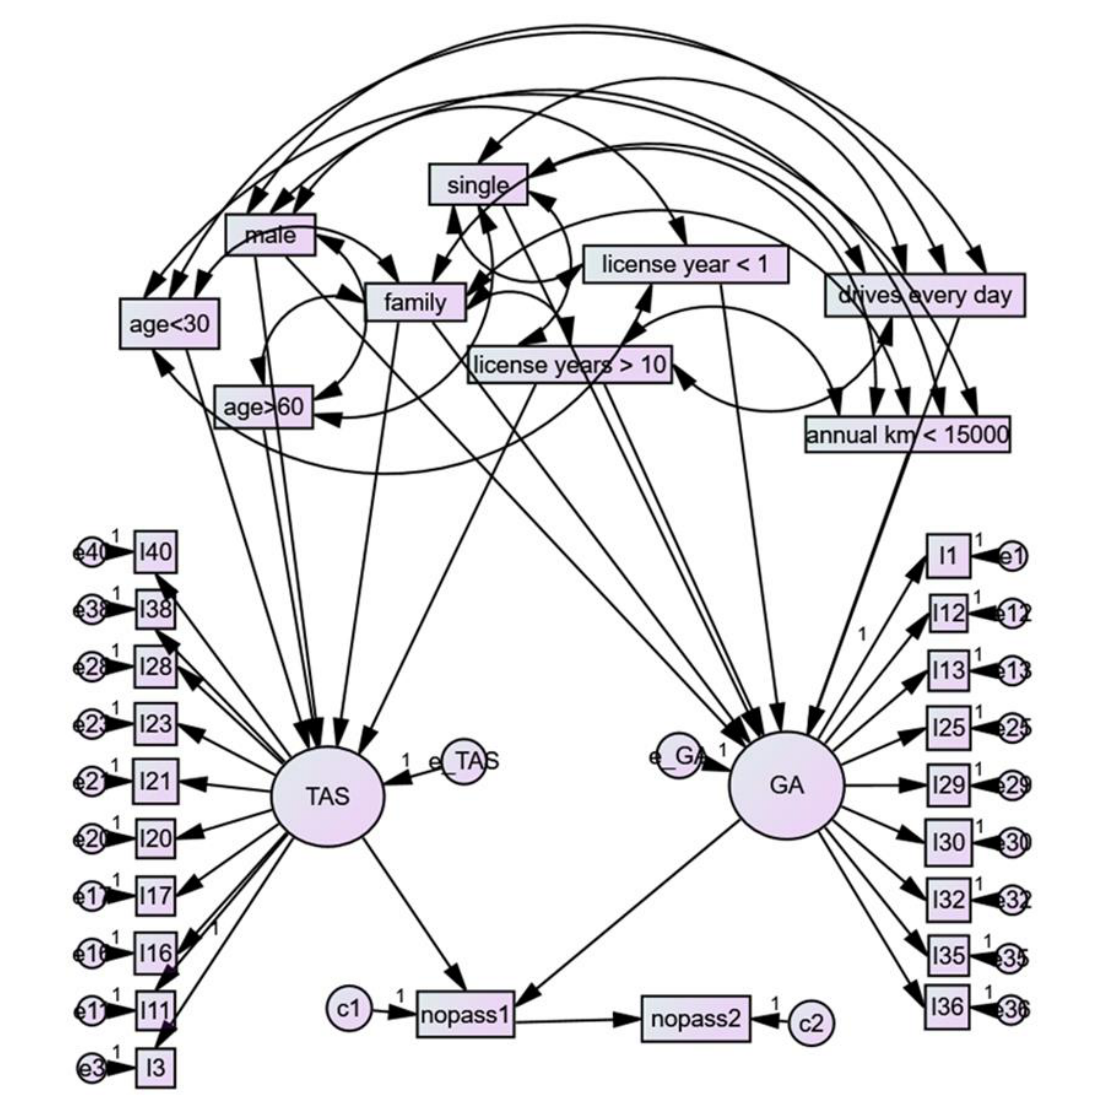
Figure 5. Correlations among the